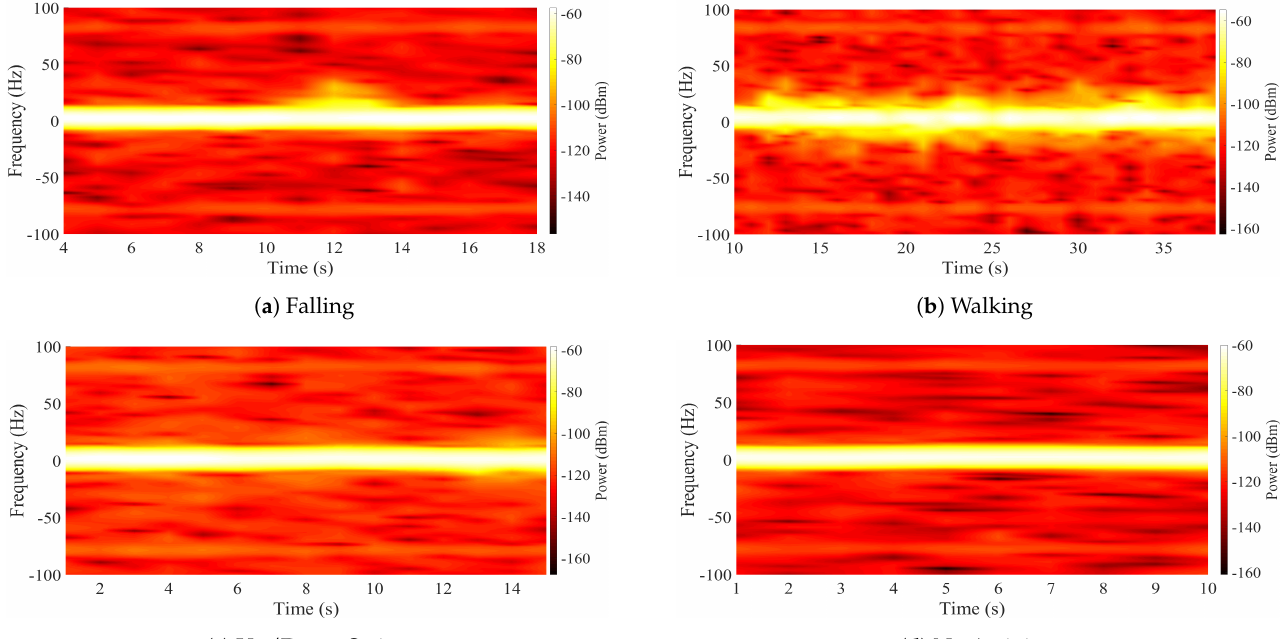
Figure 3. Spectrograms of the four activities performed in the indoor